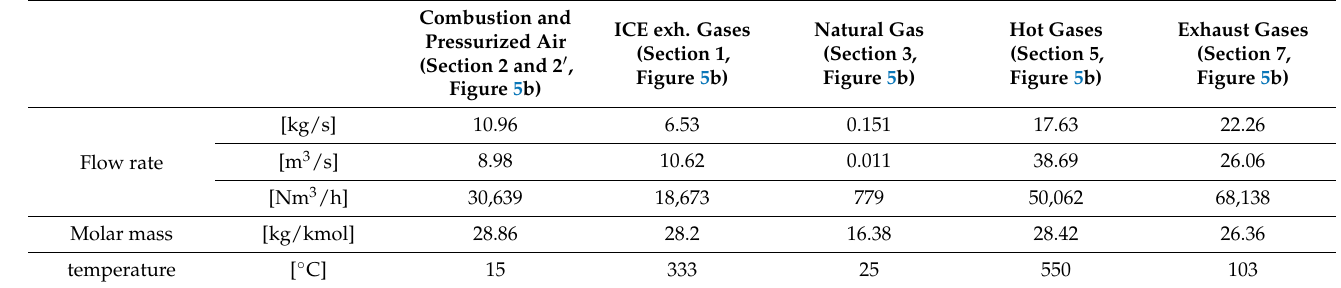
Table 8. Main results of gaseous streams for ATM 110 thermally integrated with ICE